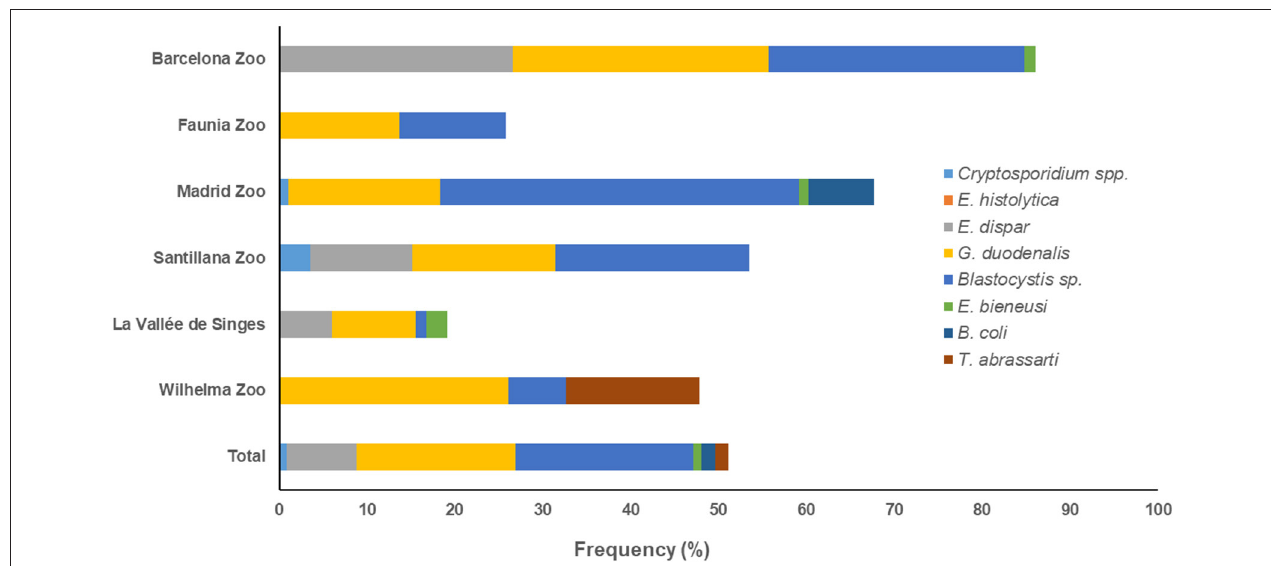
FIGURE 1 | Accumulated frequencies of enteric protist species detected in captive non-human primates by participating institution in the present